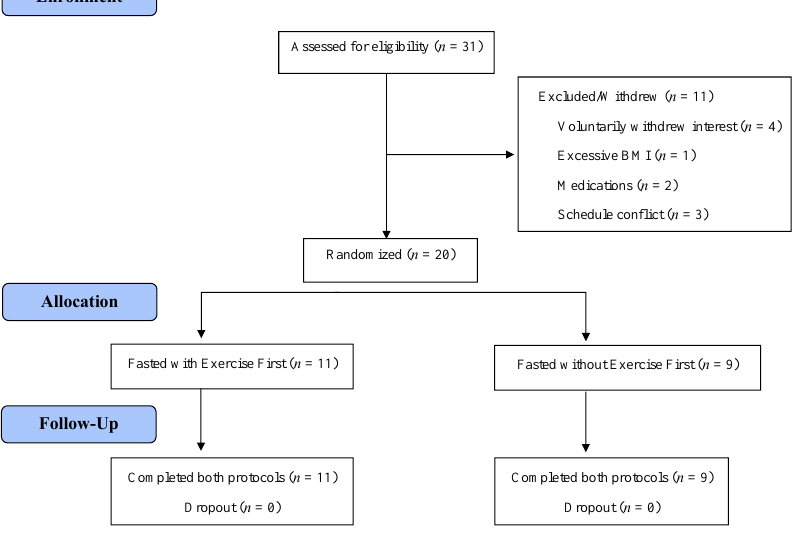
Figure 1. Participant flow diagram.